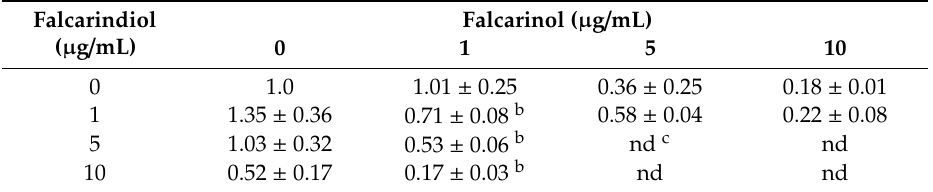
Table 1. E ff ects of di ff erent ratios of falcarinol ( 1 ) and falcarindiol ( 5 ) on the proliferation of Caco-2 cells in culture medium containing 0.625% fetal calf serum [136] a